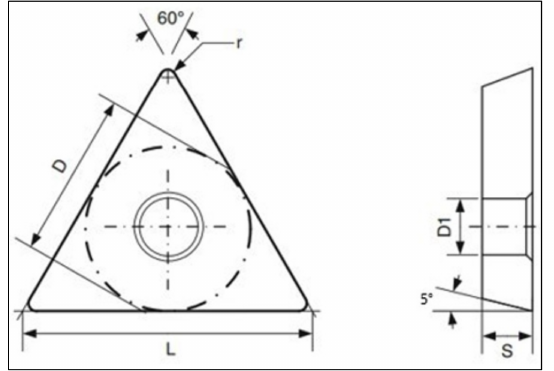
Figure 13. The parameters of the scratch tool (L = 10.5 mm, D = 6.01 mm, D1 = 2.56 mm, S = 2.74 mm, r = 0.4